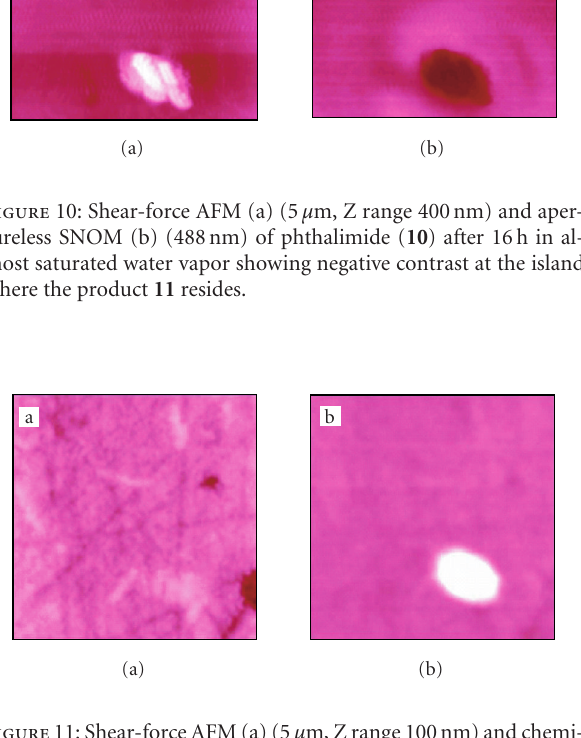
Figure 11: Shear-force AFM (a) (5 μ m, Z range 100nm) and chemi- cal contrast by SNOM (b) of a pyrite geode at the surface of polished dolomite, which cannot be traced in the 5 μ m AFM topography.